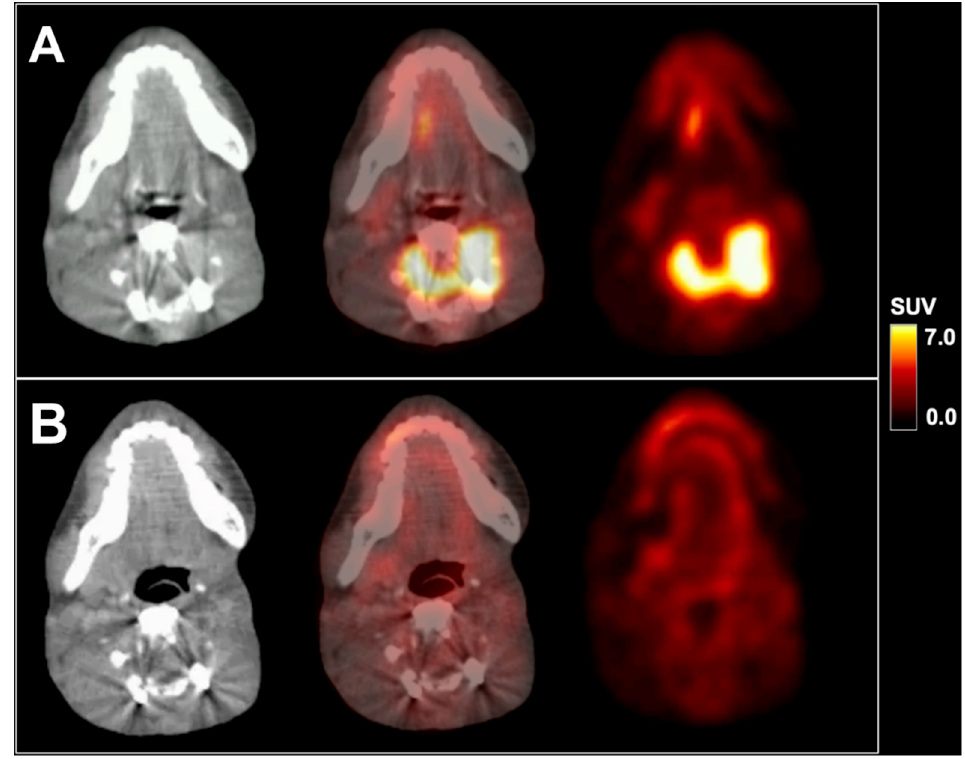
Figure 2. 18 F-FDG PET / CT in axial planes of a metastasis in the cervical spine before ( A ) and after radiochemotherapy ( B ). SUV = standardized uptake value.